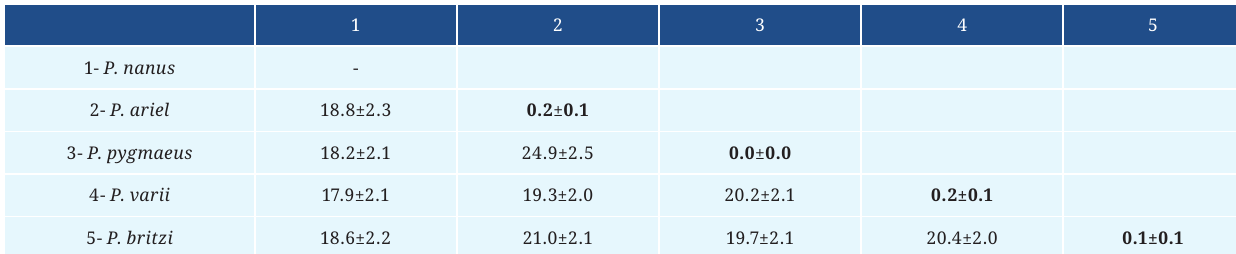
TABLE 3 | Pairwise K2P genetic distances (and standard deviation) within and among species of Priocharax . Intraspecific genetic distances are highlighted in bold. Values are presented in percentages followed by standard deviation. Number of sequences: P. ariel = 6, P. britzi = 5, P. nanus = 1, P. pygmaeus = 9 and P. varii =